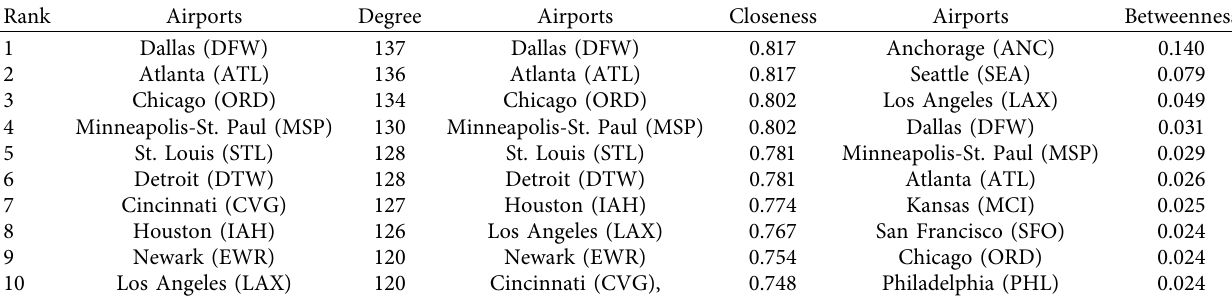
Table 3: Rankings of the US air cargo airports based on complex network metrics in 2000.